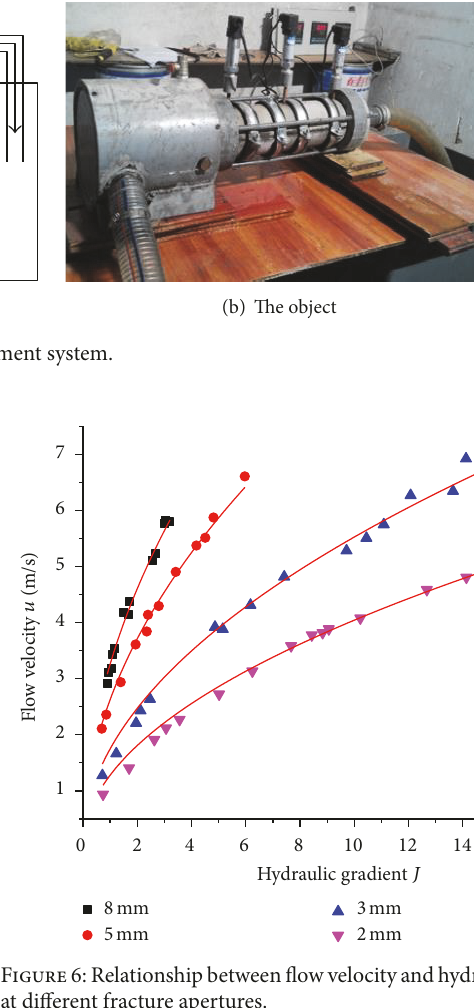
Figure 5: Hydrodynamic gradient flow curves under different roughness conditions.